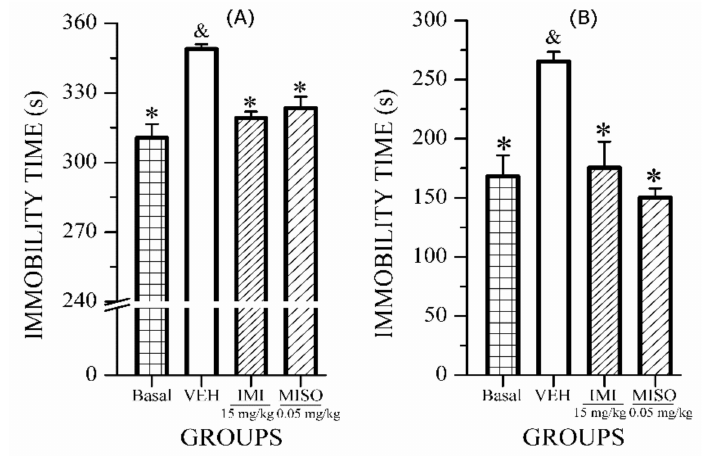
Figure 4. Effect of oral administration of drugs IMI and MISO on immobility time of ICR mice exposed to ( A ) TST and ( B ) FST. ANOVA followed by post hoc Bonferroni test (mean ± SEM) * p ≤ 0.05, in comparison with the VEH control group; & p ≤ 0.05 in comparison with the BASAL